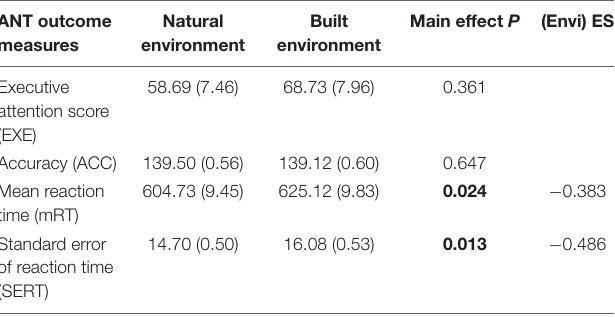
TABLE 2 | Means and standard errors for Attention Network Task (ANT) outcome measures (adjusted for baseline performance).